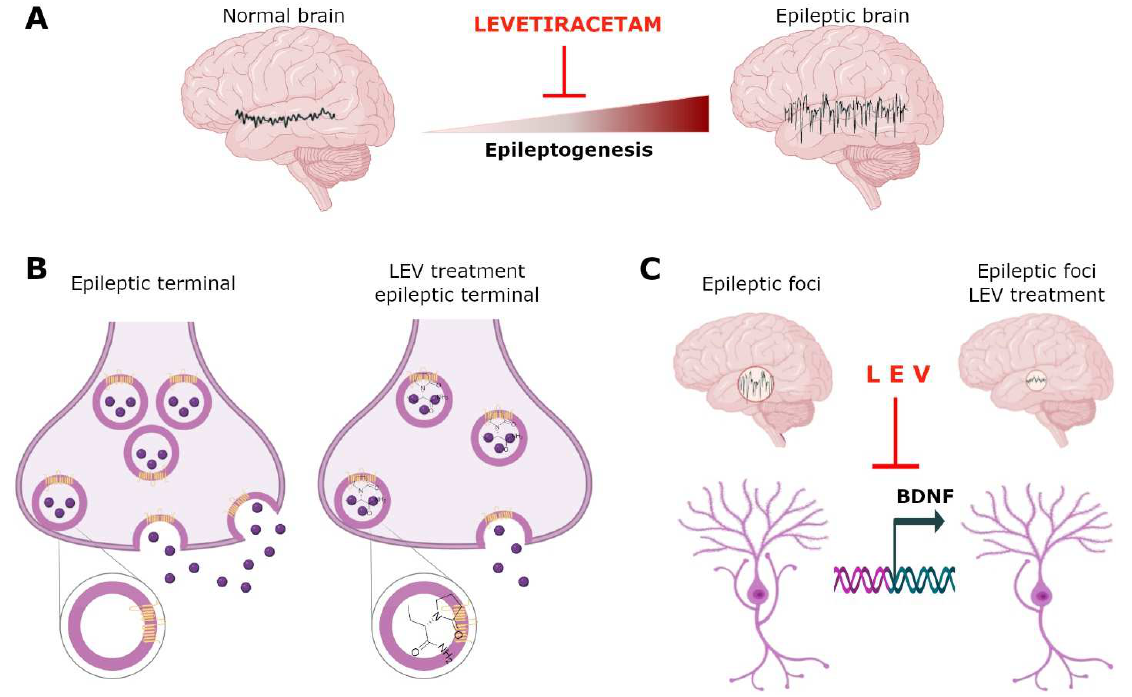
Figure 6. Putative antiepiletogenic levetiracetam (LEV) mechanism. ( A ) LEV is one of the few antiepileptic drugs (AED) able to retard or inhibit the generation of epileptic neural circuits. The mechanism through which it does is not completely elucidated, but apparently inhibiting the excessive synaptic transmission. ( B ) The binding LEV-SV2A improve the SV2A effects, diminishing the hyperexcitability and thus delays epileptogenesis. ( C ) LEV inhibit epileptic foci formation by suppressing BDNF synthesis and consequently the mossy fiber sprouting.